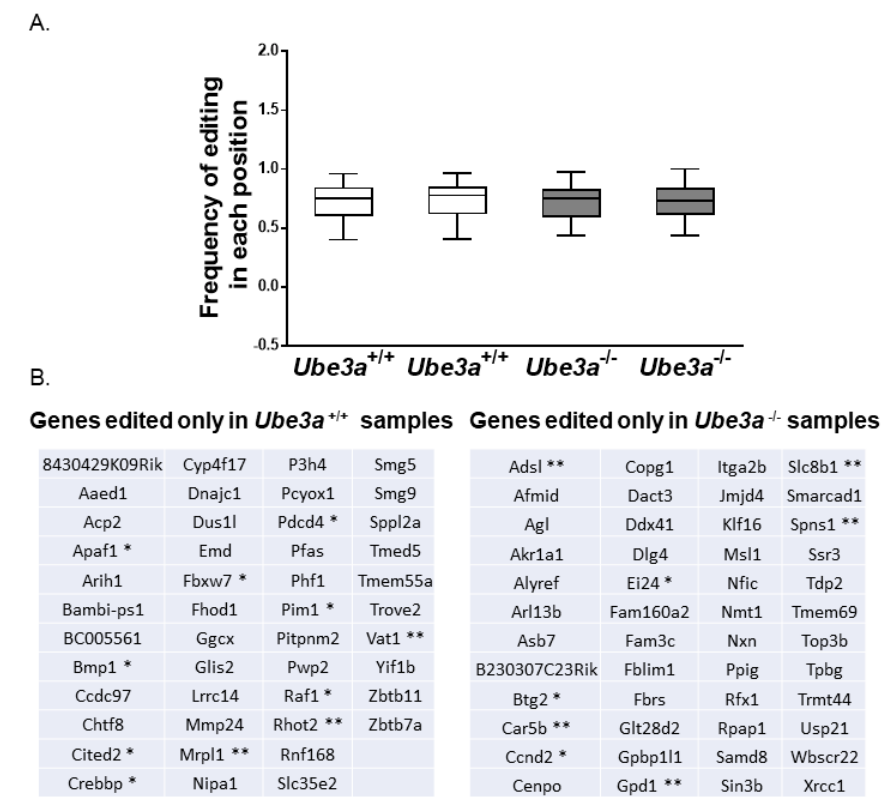
Figure 5. Differential RNA editing as determined by the GIREMI algorithm. ( A ) Box plot of RNA editing representing the frequencies of editing across the genome in each sample. The average frequency of RNA editing is not changed in Ube3a − / − compared to Ube3a +/+ MEFs. ( B ) Genes uniquely edited in Ube3a +/+ and Ube3a − / − MEFs (* signifies apoptosis-associated genes, and ** signifies mitochondria-related genes). It is known that mRNA expression does not always directly translate to protein abundance